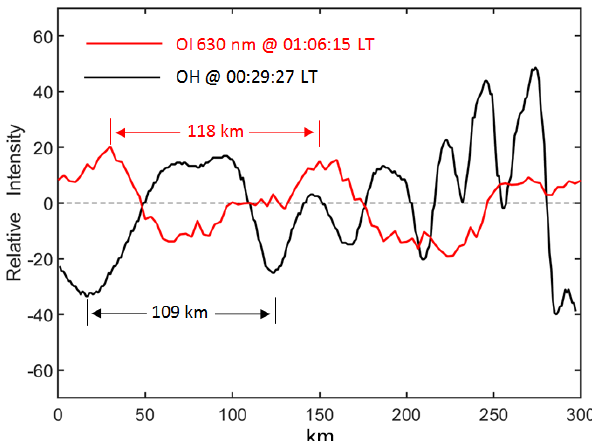
Figure 12. OH (black) and OI 630nm (red) airglow relative- intensity variations. The OH relative-intensity variation is obtained as in Fig. 11. The OI 630nm relative-intensity variation is from the red dotted line in Fig. 6 at